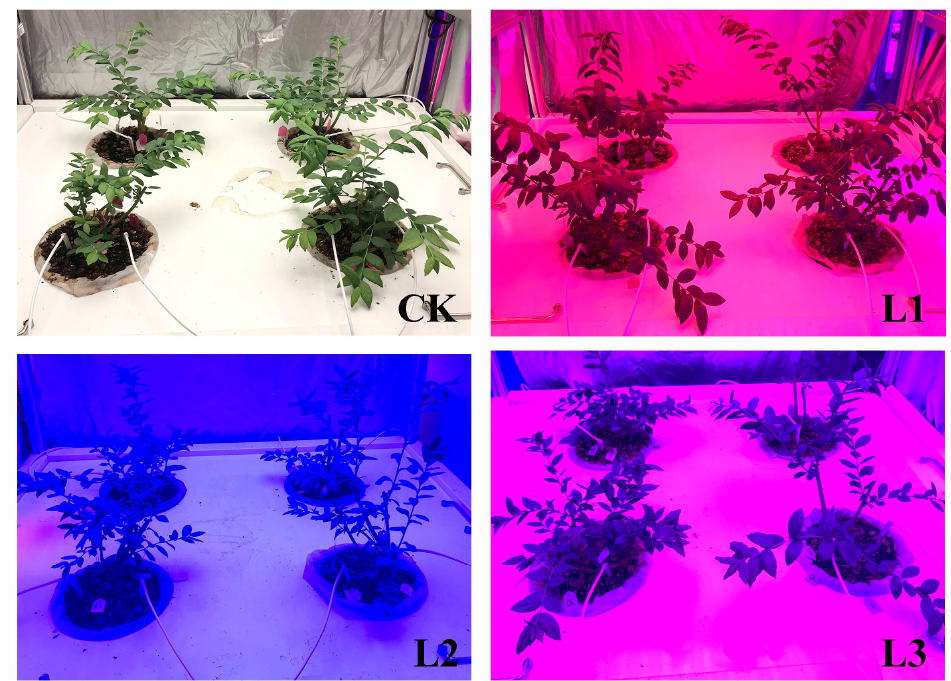
Figure 7. Blueberries grown under white (CK), red (L1), blue (L2), and 60% red + 40% blue (L3) light qualities in Room 2 of the plant factory. Table 4. Effects of different light qualities on the growth of ‘Misty’ in plant factory with artificial lighting.